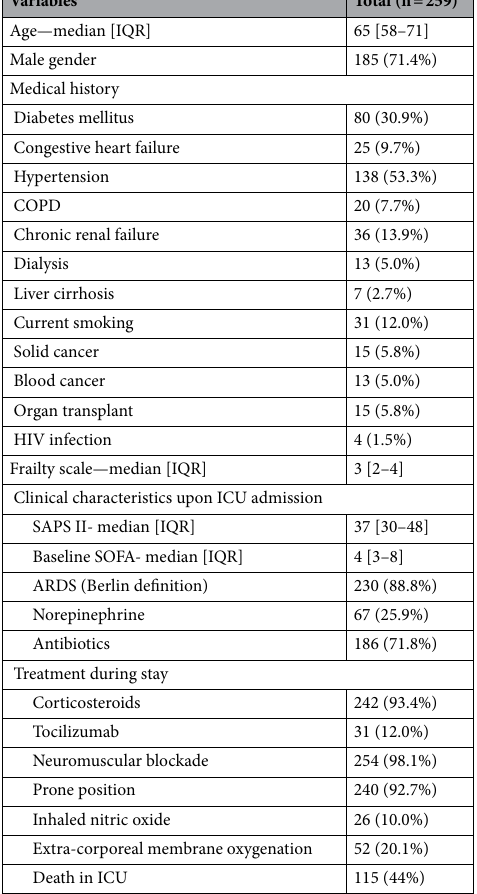
Table 1. Characteristics of patients with Coronavirus disease 19 (COVID-19) (n = 259). COPD chronic obstructive pulmonary disease, HIV human immunodeficiency virus, SAPS II Simplified Acute